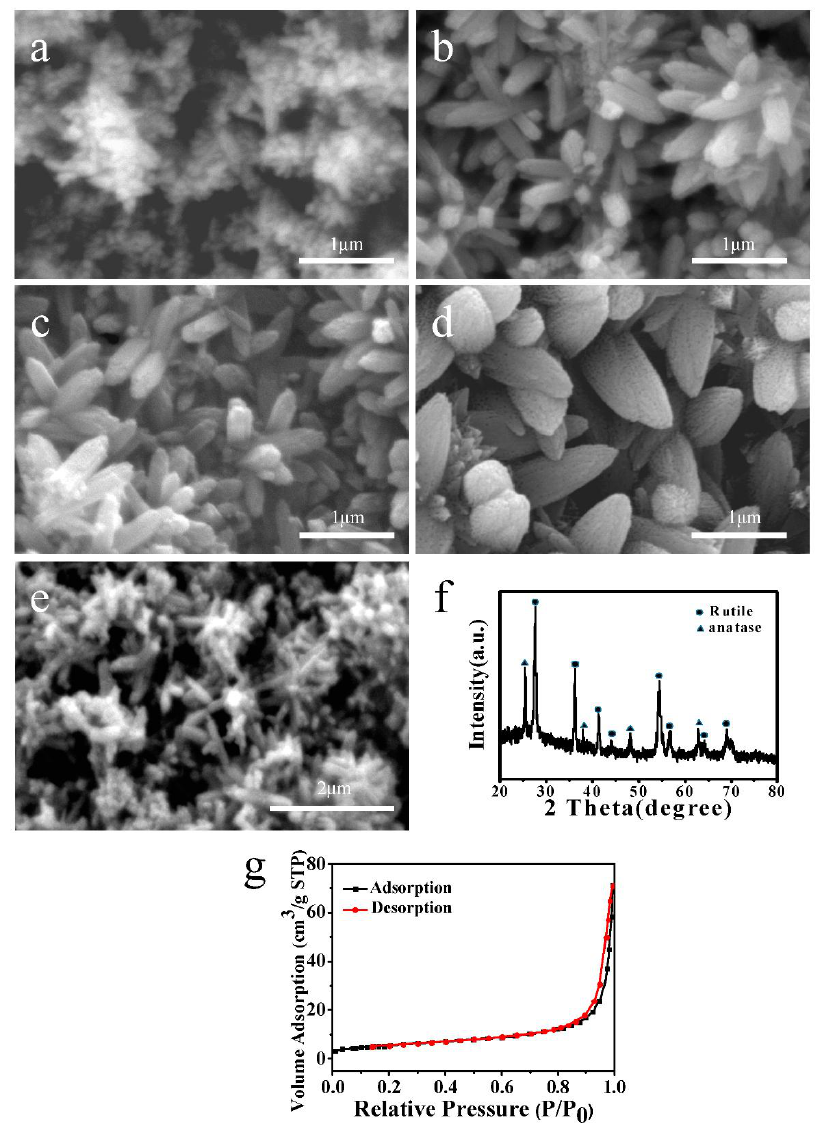
Figure 3. FESEM images of Ns prepared with different reaction times: ( a ) 12 h; ( b ) 18 h and ( c ) 24 h. ( d ) FESEM image of Ns prepared without the addition of titanium dioxide powders for 18 h. ( e ) FESEM image, ( f ) XRD pattern and ( g ) N 2 adsorption-desorption isotherm of Ns calcined at 400 °C.